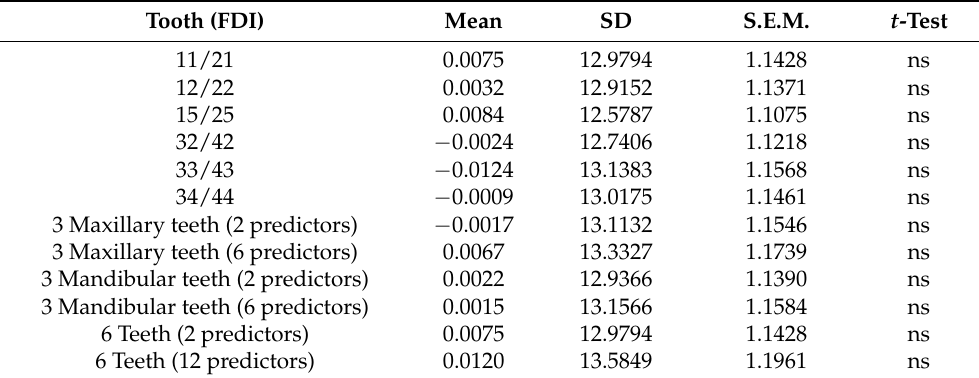
Table 4. Comparative analysis of measured variables for all possible combinations a . Tooth (FDI)